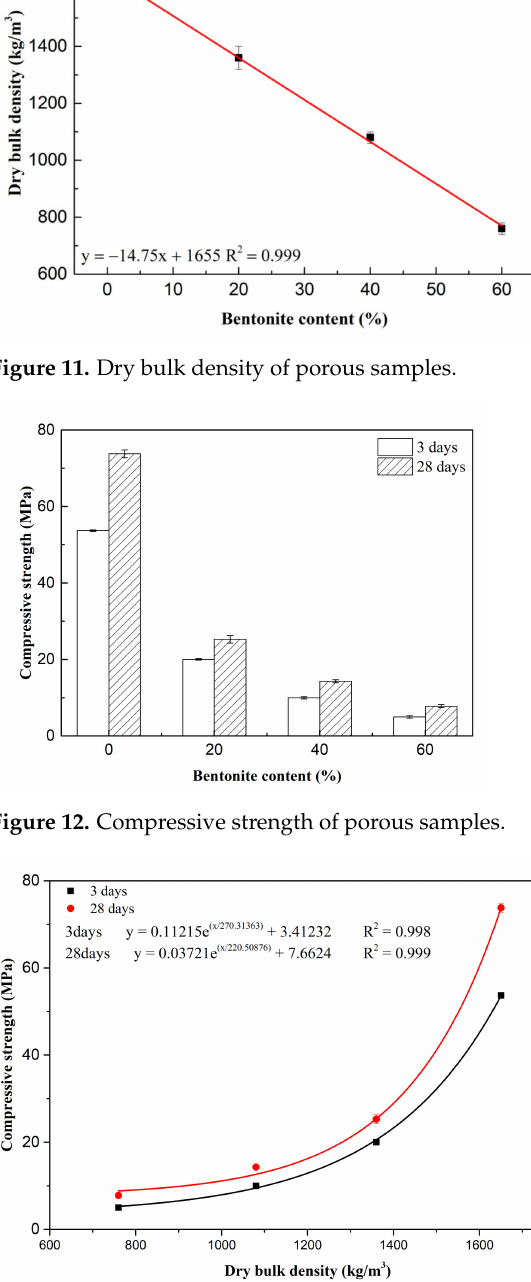
Figure 13. Relationship between dry bulk density and compressive